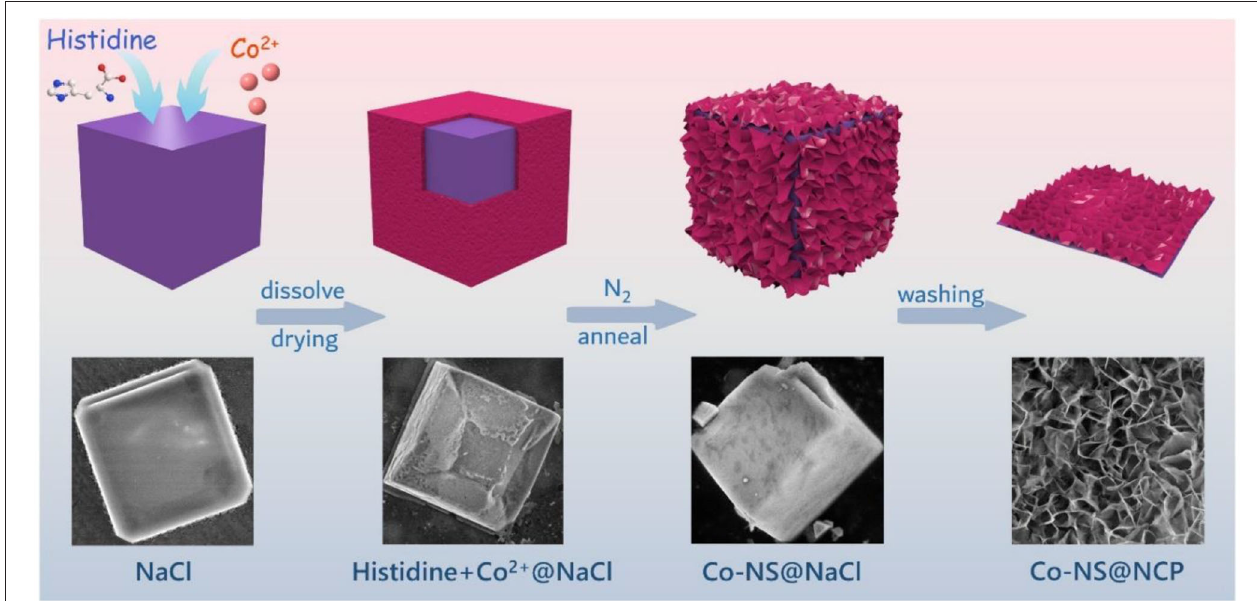
FIGURE 1 | Schematic illustration and SEM images of the formation process of Co-NS@NCP